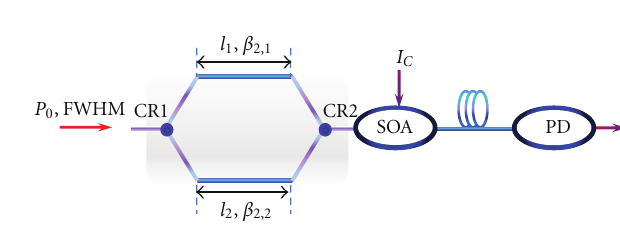
Figure 5: UWB pulse generation